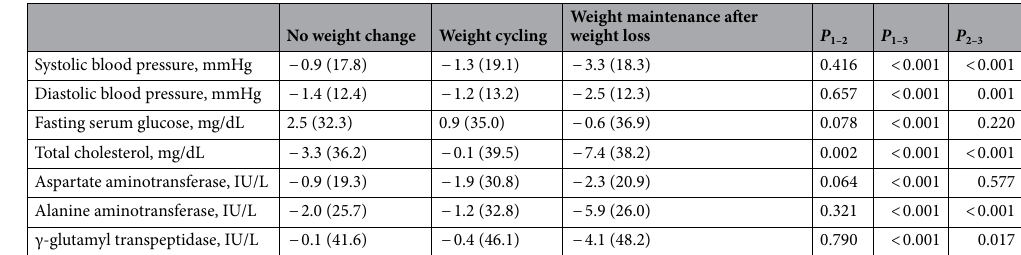
Table 4. Change in blood pressure, fasting glucose, total cholesterol, and liver function at 3rd health examination according to the body mass index maintenance status. Data are mean (standard deviation). Pooled P value calculated by t-test. P 1–2 : comparison between maintenance and weight gain after weight loss groups. P 1–3 : comparison between maintenance and weight loss maintenance groups. P 2–3 : comparison between weight gain after weight loss and weight loss maintenance groups.